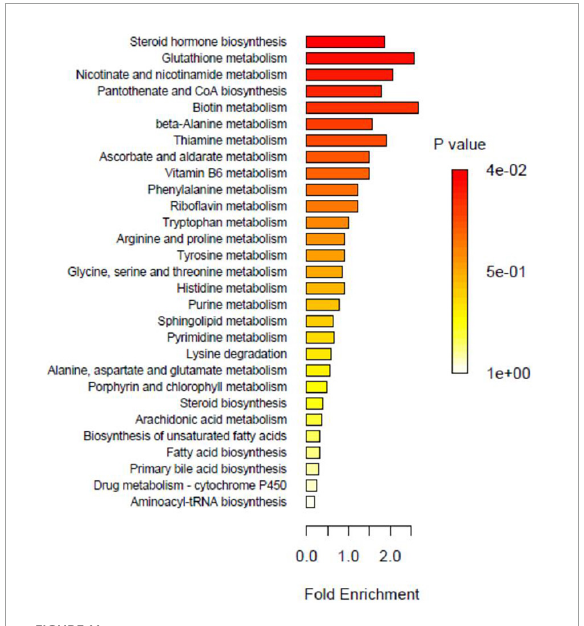
FIGURE11 Over representation analysis (ORA) enrichment